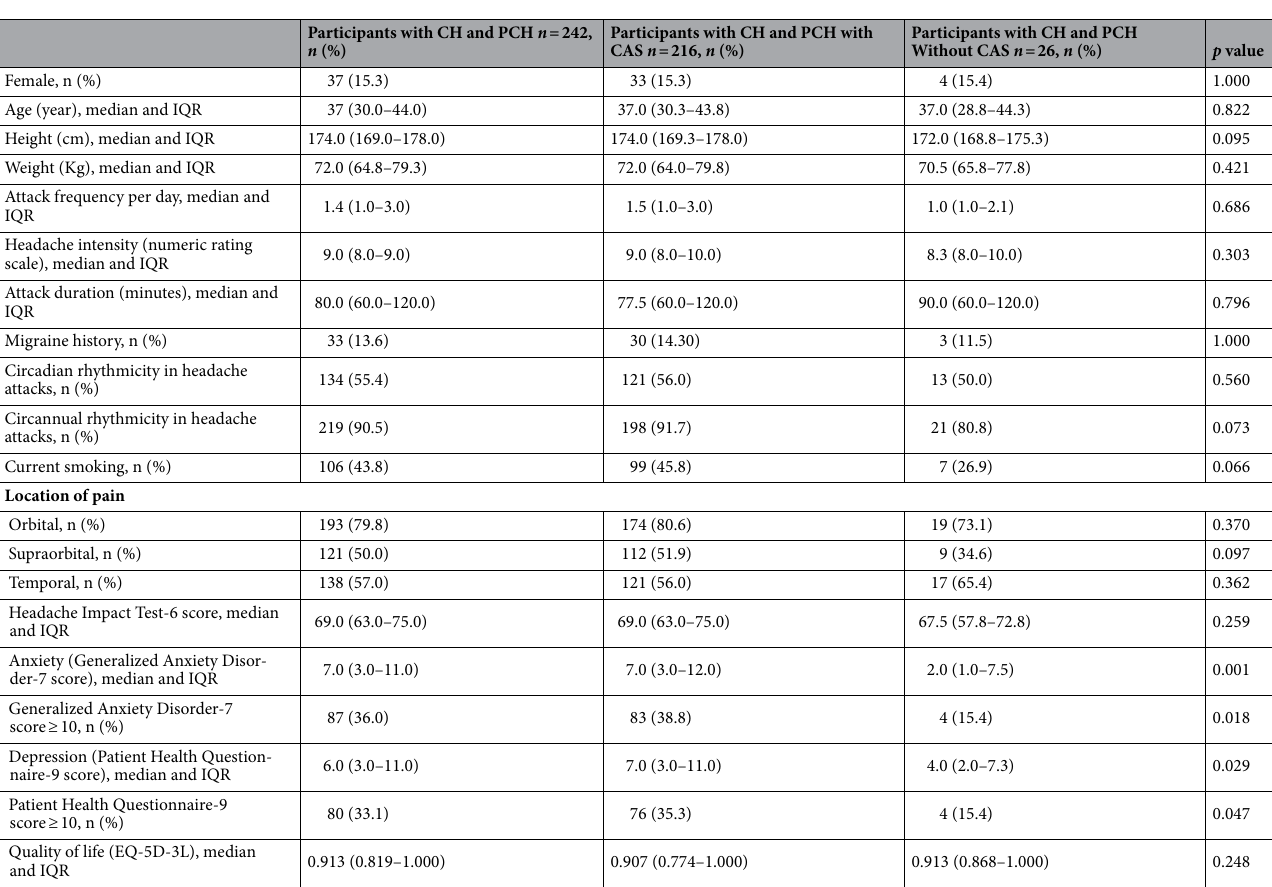
Table 2. Clinical features of participants with CH and PCH according to the presence of CAS. CAS cranial autonomic symptoms, CH cluster headache, EQ-5D-3L the 3-level version of EuroQol five-dimension scale, IQR interquartile range, PCH probable cluster